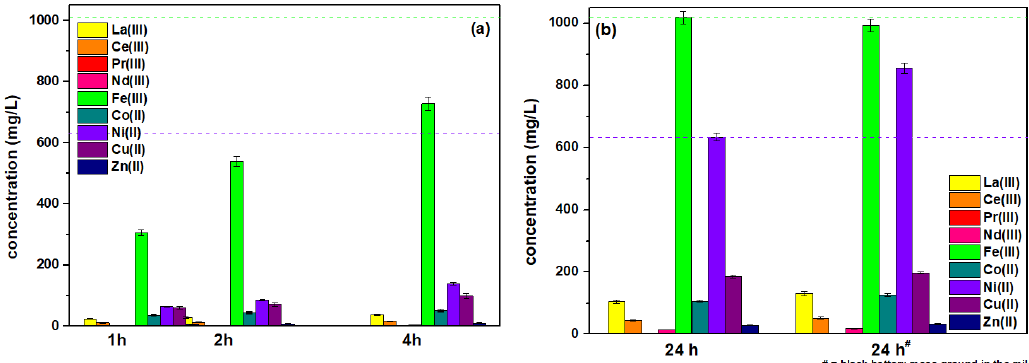
Figure 2. Concentration of La(III), Ce(III), Pr(III), Nd(III), Fe(III), Co(II), Ni(II), Cu(II), and Zn(II) in the PLS obtained from the black battery mass using 0.6 M CA ( a ) Without and ( b ) After the additional grinding (#) after 1, 2, 4, and 24 h leaching. The green dash line represents the values of Fe(III) concentration and the purple one represents Ni(II) after H 2 SO 4 leaching under the same conditions.